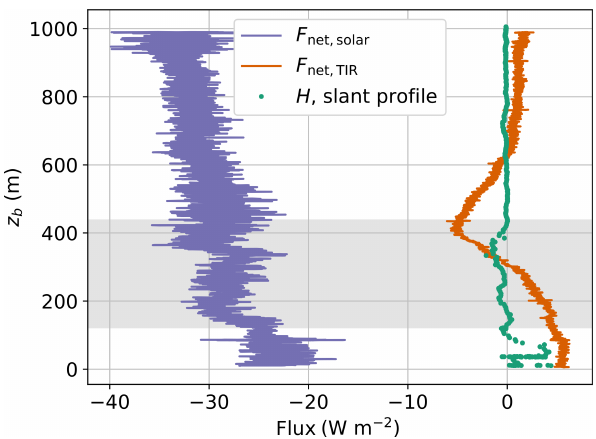
Figure 14. Solar and TIR net irradiance F net and virtual heat flux H on 14 June. The virtual heat fluxes are based on the slant profile. The shaded area represents the lower cloud